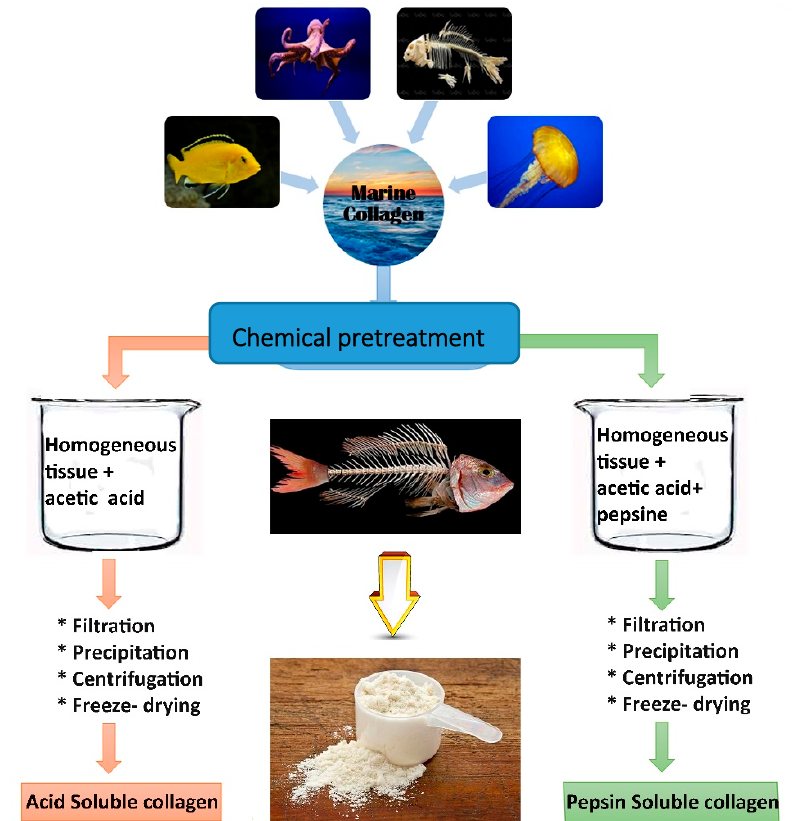
Di ff erence between acid-soluble collagen (ASC) and pepsin soluble collagen (PSC) Figure 3. Difference between acid-soluble collagen (ASC) and pepsin soluble collagen (PSC) extraction extraction methods.